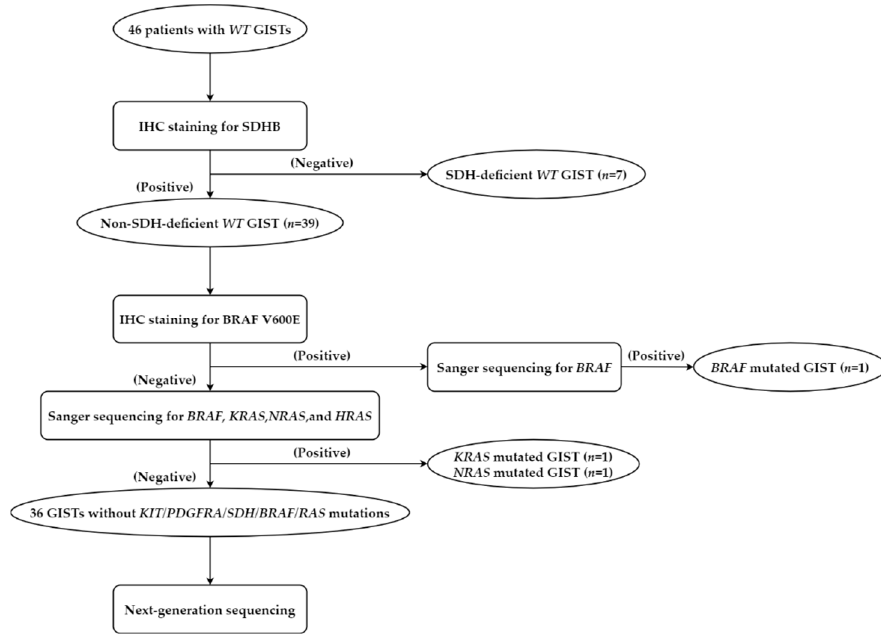
Figure 1. Flow diagram of preliminary testing of WT